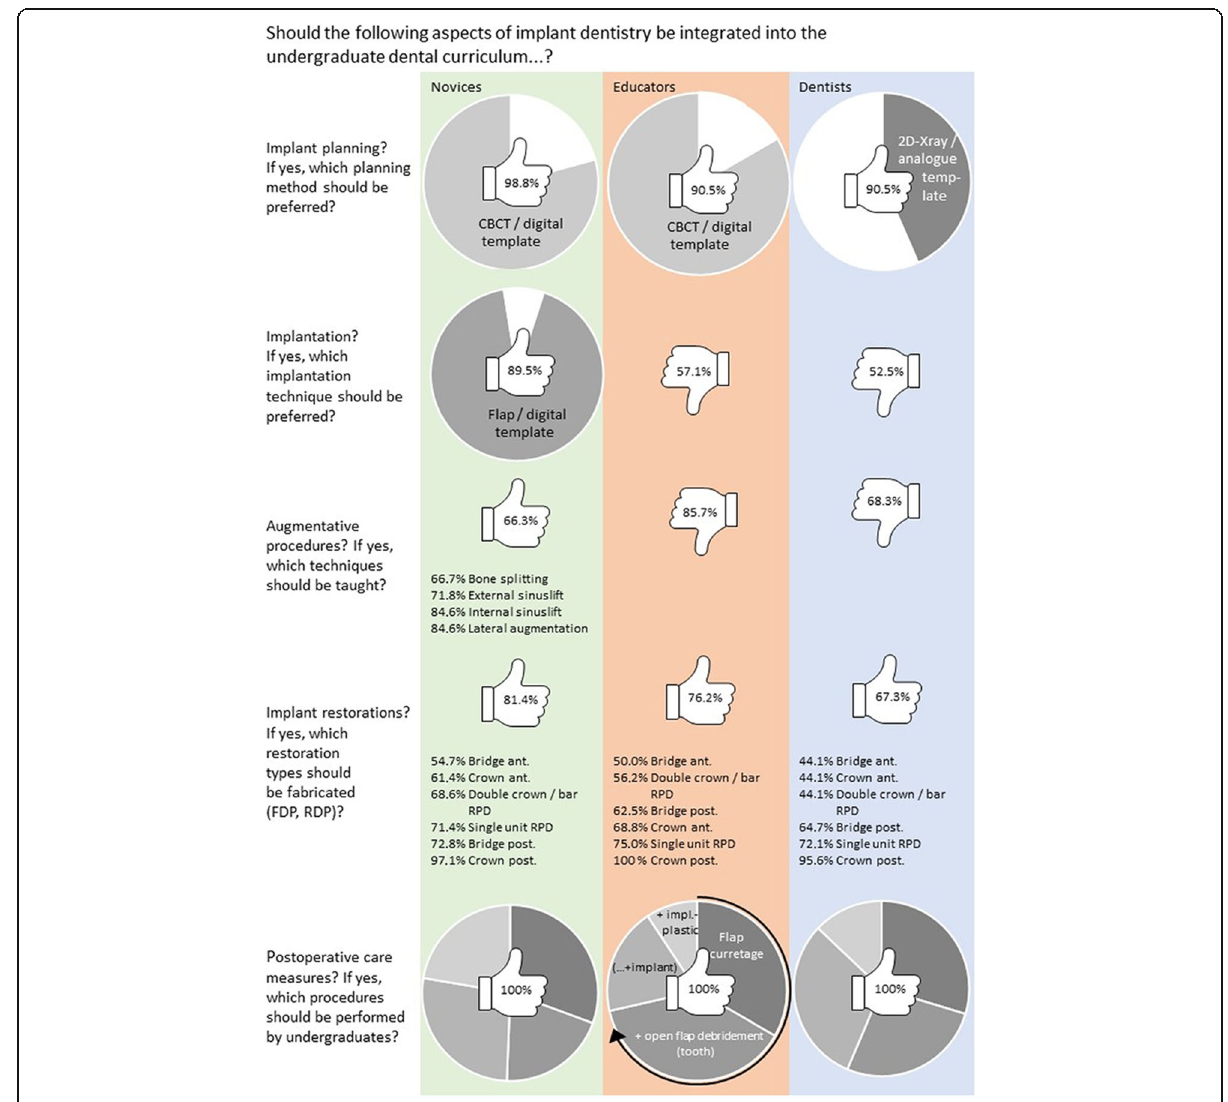
Fig. 3 Participants ’ answers to questions about content that should be taught in a dental curriculum. The percentages within the thumbs indicate acceptance (thumb up) or rejection (thumb down) within the three groups (i.e., novices, educators, and dentists). CBCT, cone beam computed tomography; FPD, fixed partial denture; RPD, removable partial denture; ant., anterior (i.e., incisors, canines); post., posterior (i.e., molars,